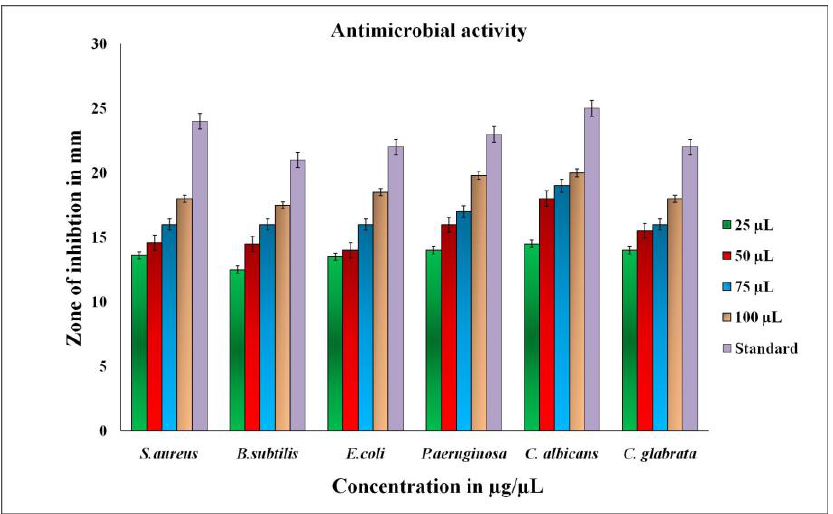
Figure 9. Graphical representation of antimicrobial activity showing the zone of inhibition to synthesized RsFb-AgNPs, and standard reference against tested microorganisms. Table 1. MIC and MBC values of synthesized RsFb-AgNPs treated against selected bacterial strains.